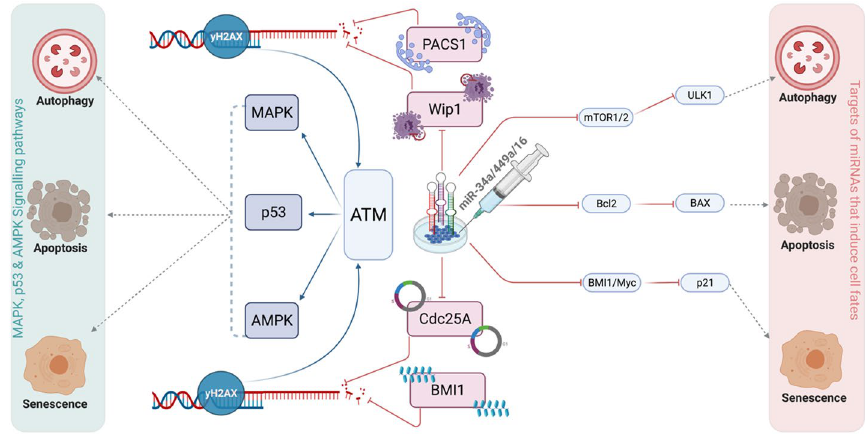
Figure 8. Schematic illustration depiciting the role of three miRNAs (miR-34a, miR-449a, and miR-16) at the G1/S checkpoint which can modulate multiple DDR signaling pathways in HeLa